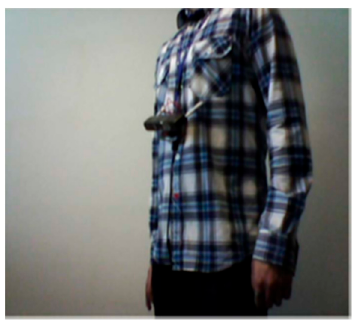
Figure 28. The proposed device [51].